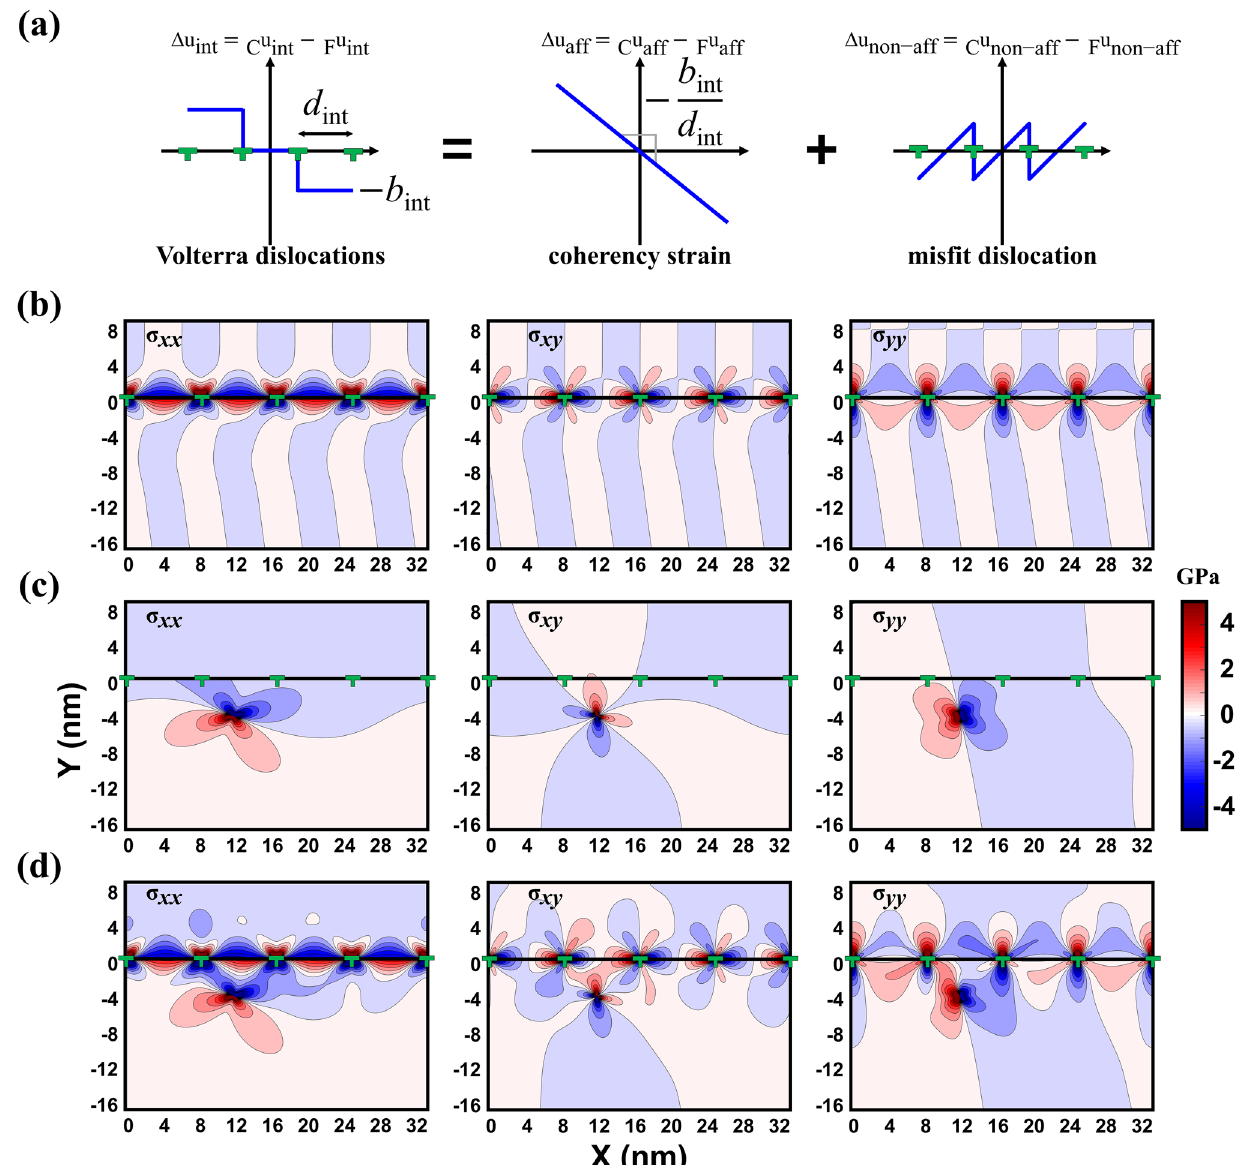
Figure 2. ( a ) The relative displacement field of arrays of Volterra dislocations at the interface, ( b ) the spatial stress distribution induced by the arrays of misfit dislocations at the interface, ( c ) the spatial stress distribution induced by the lattice dislocation within the ferrite layer and ( d ) the spatial stress distribution induced by the arrays of misfit dislocations and lattice (C) phase. Although the stress intensity is varied by the dislocation core-width 34 , we assumed the dislocations as the Volterra dislocation to solve the anisotropic linear elasticity theory 35–37 because the dislocation core- width does not significantly change the overall spatial stress distribution except for core-region (2 w = 26 represents half-width of misfit dislocation core). For computing the stress field induced by the misfit disloca- tions κ σ int ( x 1 , x 2 ) , we assumed that (i) the interface atoms experience stepwise relative displacement (cid:31) u int near the misfit dislocations (see Fig. 2a), (ii) no net traction exists along the interface, and (iii) the far-field stress induced by the arrays of Volterra dislocations and coherency stress satisfy the mechanical equilibrium 37 . The stepwise relative displacement (cid:31) u int is expressed as a combination of the affine (cid:31) u aff = C u aff − F u aff and non- affine (cid:31) u non-aff = C u non-aff − F u non-aff relative displacement, where κ u aff and κ u non-aff represent the affine and non-affine displacements in κ-phase, respectively. The affine relative displacement (cid:31) u aff is determined from the coherency strain to satisfy macroscopic geometric compatibility between ferrite and cementite blocks. The non- affine relative displacement (cid:31) u non-aff is given by the non-uniform relative displacement to minimize the atomic mismatch between ferrite and cementite atomic layers. For computing the stress field induced by the lattice dislocation κ σ lat ( x 1 , x 2 ) , we assumed the displacement continuity across the interface and the zero net traction along the interface 35 . The spatial stress distribution is depicted in Fig. 2b–d. The detailed descriptions to compute